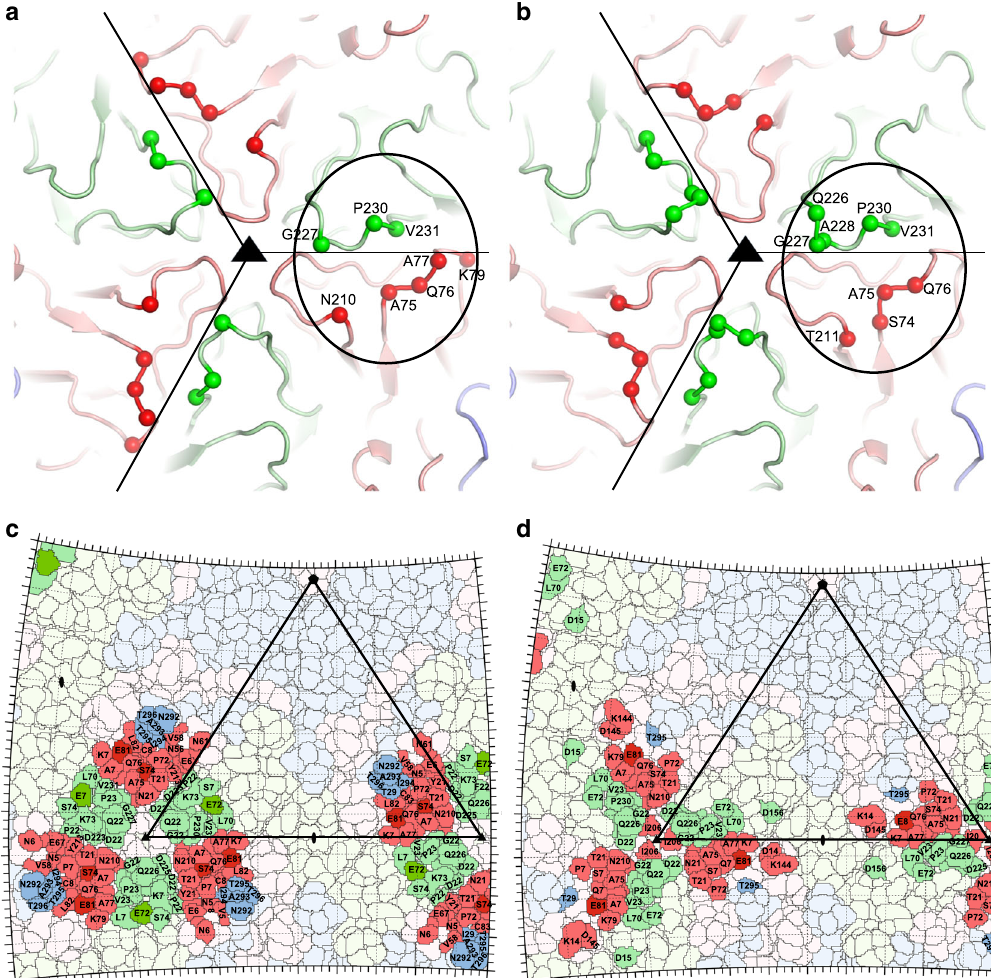
Fig. 6 38-1-10A and 38-3-11A interact with the same epitope of EV71. The core region of the epitope that interacts with 38-1-10A ( a ) and with 38-3-11A ( b ). Capsid proteins of EV71 are shown as ribbons with VP1, VP2 and VP3 coloured in light blue, pale green and salmon, respectively. C α s of viral residues that have direct contact with CDR H3 or L3 ( ≤ 4.0 Å) are drawn as bright spheres. The core region of one epitope is circled and black lines mark the pentamer boundaries. c , d Roadmaps of the virus surface with colour scheme as in a and an icosahedral subunit outlined in black lines. Residues in contact with 38-1-10A ( c ) or 38-3-11A ( d ) are highlighted in the corresponding viral protein colour and escape mutations are shown in bright